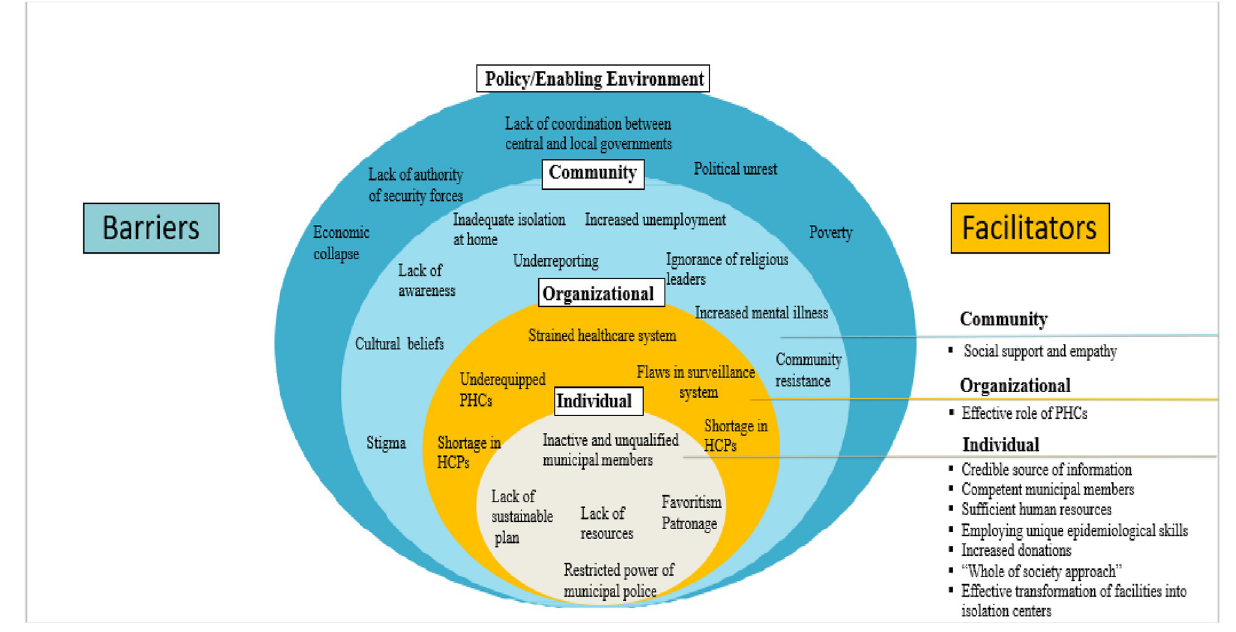
Fig 2. The ecological framework: Barriers and facilitators affecting municipalities’ response to COVID-19.